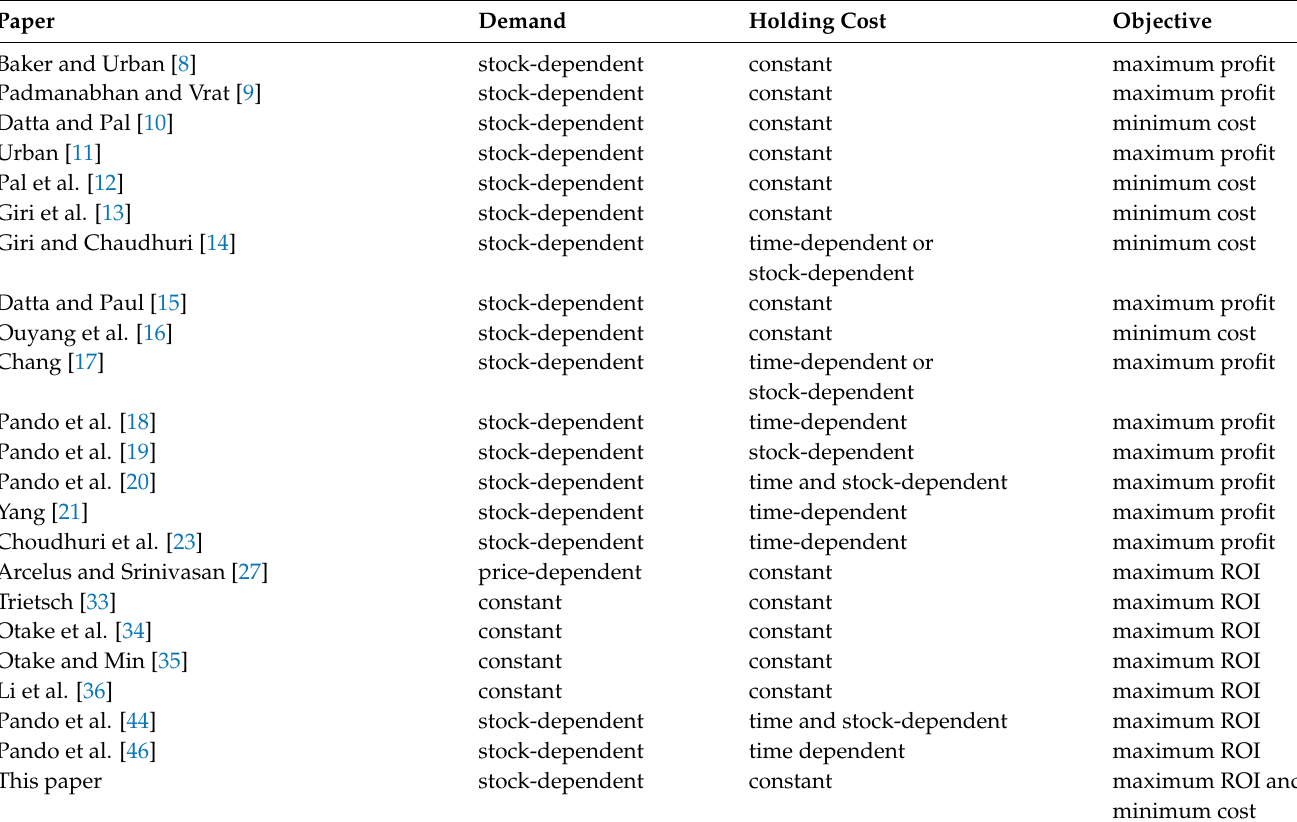
Table 1. Major characteristics of the main publications on inventory models cited in the